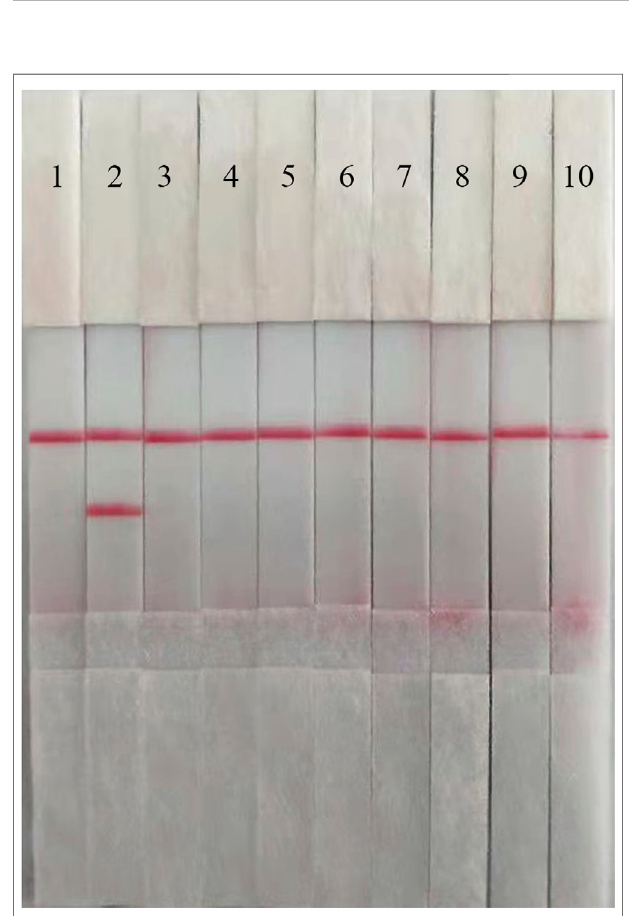
FIGURE 3 | The speci fi city of ASFV RAA-strip. C is a control line. T is a test line. Lane 1 is a negative control. The speci fi city test result of ASFV RAA- strip using 9 different pig viruses, including ASFV, CSFV, PPV, (PCV2, FMDV, SVV, PRV, PRRSV,